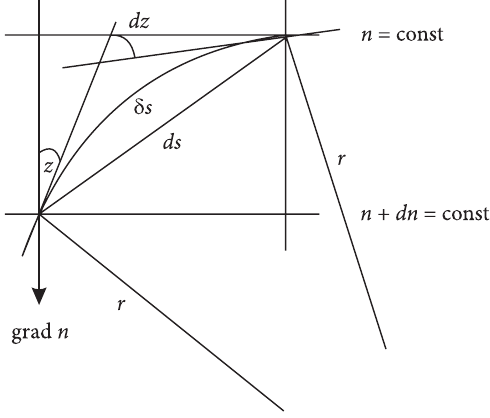
Figure 5. Effect of refraction of air on propagating wave (actual path length s , the straight line s (chord), and z zenith angle) (Torge,